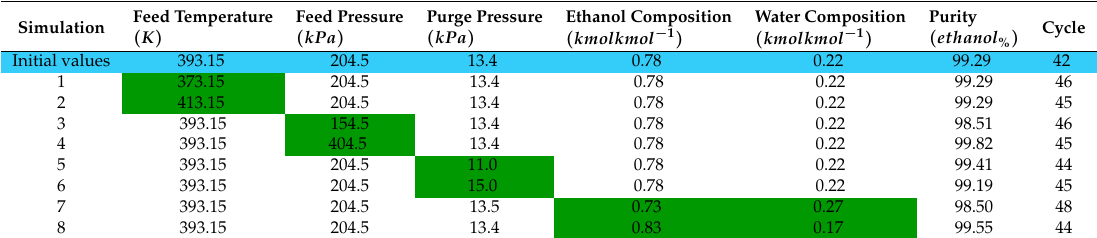
Table 8. Comparative table of values used in simulations to find the optimal values of the PSA process. Simulation